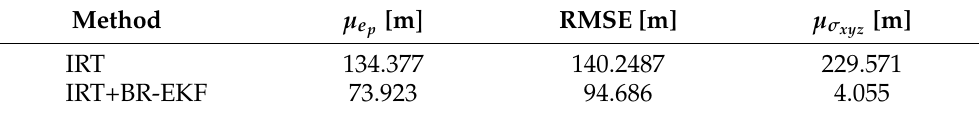
Table 9. Results from the Porto de Mós experimental procedure simulated with a ground perspective.